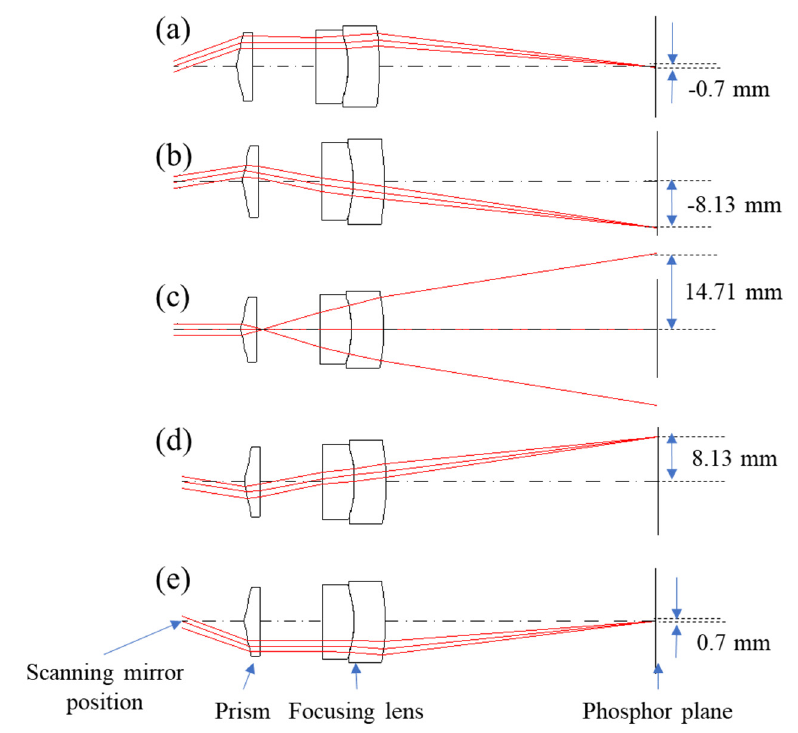
Figure 5. Ray tracing according to scanning angle in designed scanning system. ( a ) 12°, ( b ) 5°, ( c ) 0°, ( d ) − 5°, and ( e ) − 12°. ( d ) − 5 ◦ , and ( e ) − 12 ◦ .